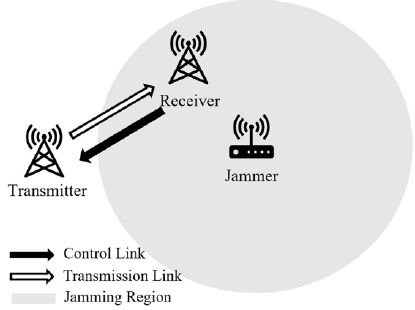
Figure 1. Schematic diagram of the system